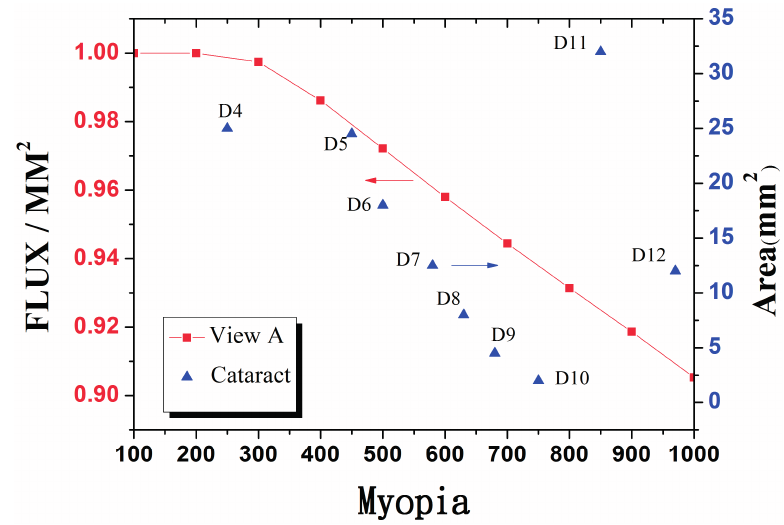
Figure 11. According to the calculation results of the parameters in Table 1, the blue spot refers to the area in Table 1. This is defined as the area of periodic structure multiplied by the number of